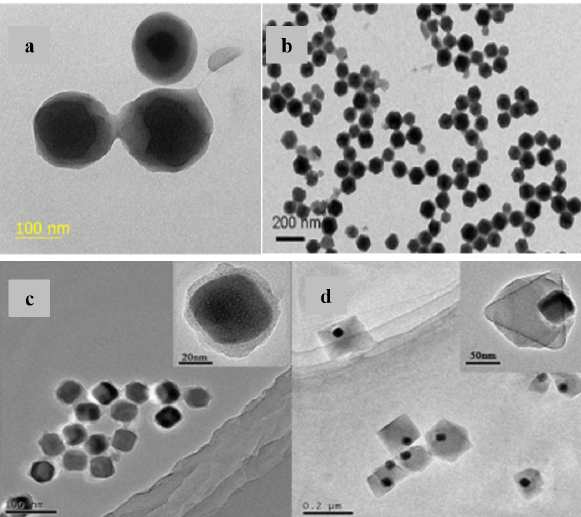
Figure 9: Dual-modal UCL/MR in vivo imaging. Representative UCL imaging of subcutaneous KB tumor-bearing mice and dissected or- gans of the mice sacrifi ced 24 h after intravenous injection of a) UMP-FAs and b) UMPs. 1, heart;2, kidney; 3, lung; 4, liver; 5, spleen; 6, KB tumor.; Representative T 2 -MRI image of KB tumor-bearing mice 24 h after intravenous injection of c) targeted and d) nontar- geted UMPs